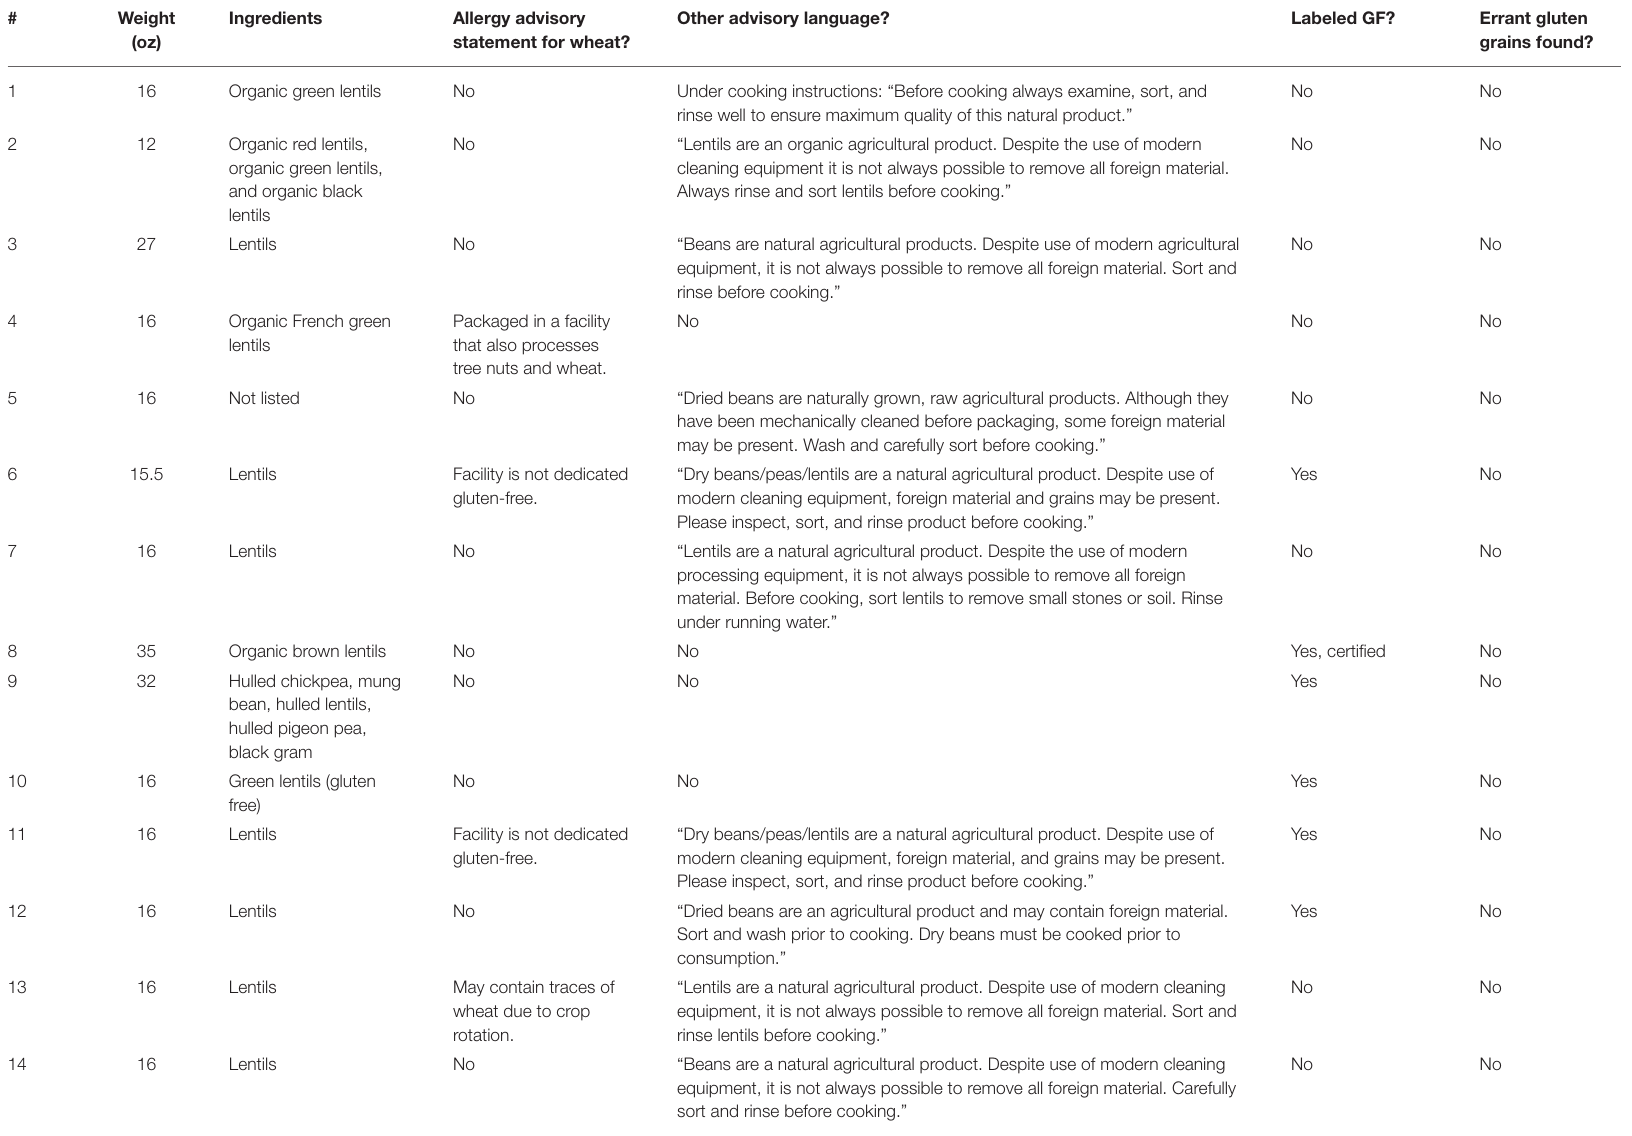
TABLE 1 | Errant gluten-containing grain findings and labeling language on packages of lentils hand sorted in 2021. # Weight Ingredients Allergy advisory Other advisory language? Labeled GF? Errant gluten (oz) statement for wheat?